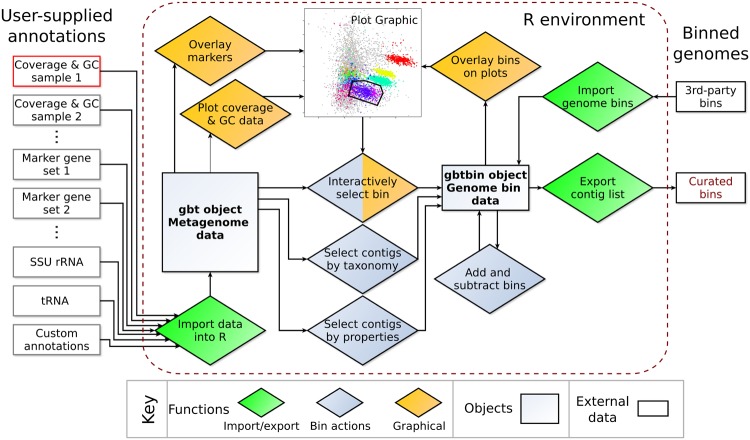
Diagram of objects and functions available in the gbtools package. All user-supplied annotation data associated with one metagenome (left) are integrated into a single gbt object. For each metagenome, the GC% and coverage data from at least one read library must be supplied, whereas all other input data are optional. Functions (diamonds) in the gbtools package allow import and export of data (green), visualization with plots and overlays (orange), and creating or manipulating of bins (blue).